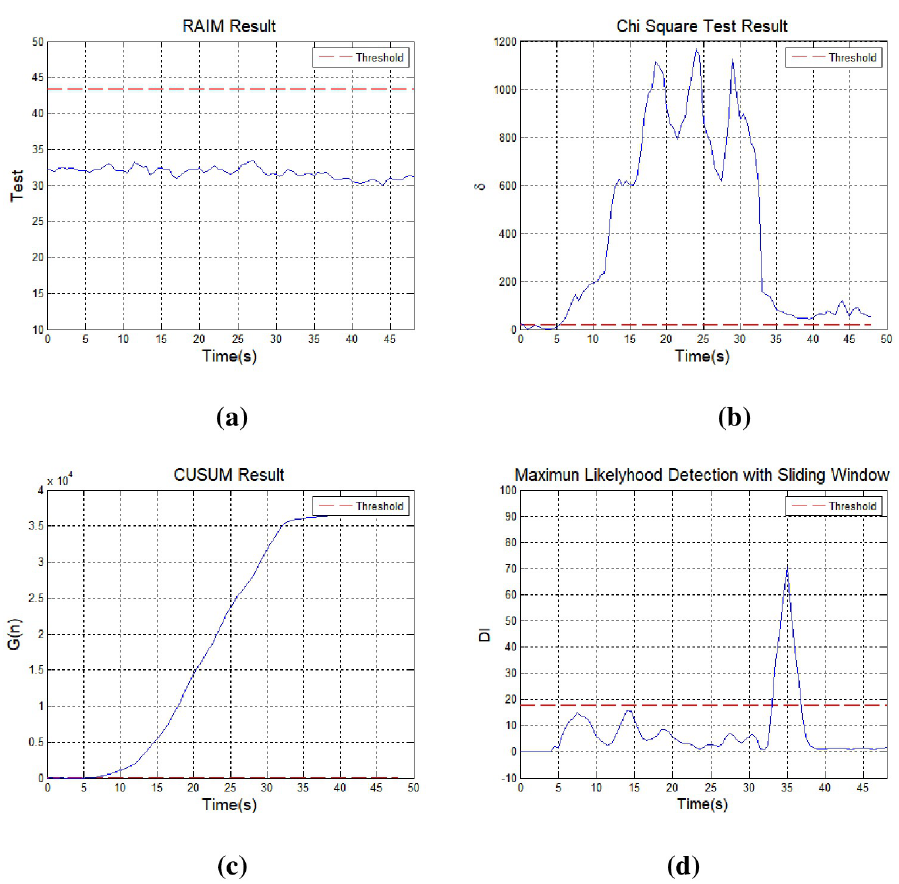
Fig 9. Spoofing signal detection results obtained using receiver autonomous integrity monitoring: (a) RAIM, (b) chi-square test, (c) CUSUM, and (d) sliding window.